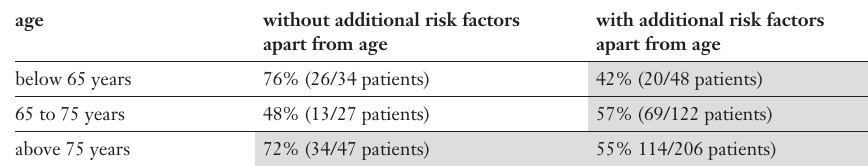
Percentage of pa- tients without antico- agulation, stratified to age and additional risk factors.